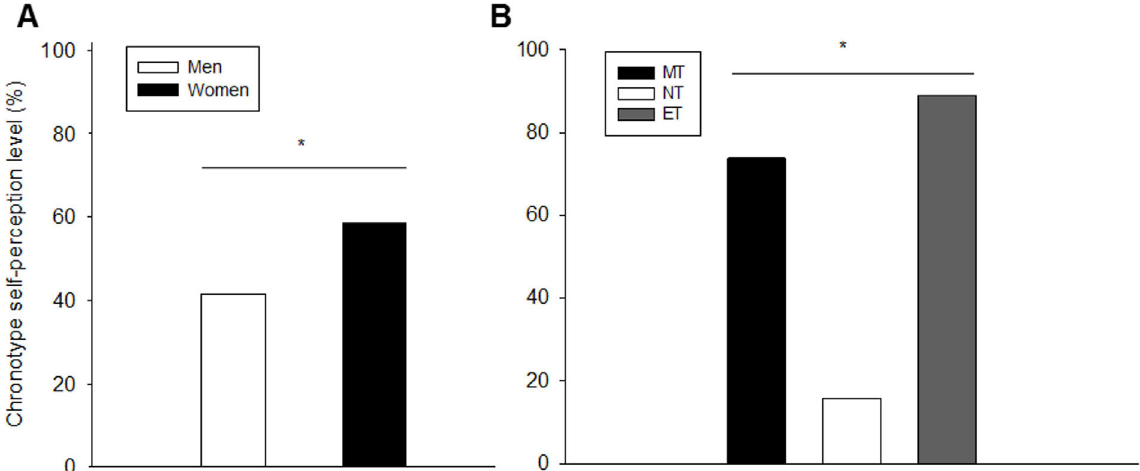
Figure 2. - Chronotype self-perception level (%) by gender (A) and chronotypes (B). MT (morning-types), NT (neither-types), ET (evening-types). *denote difference from MT and NT to expected values ( p <